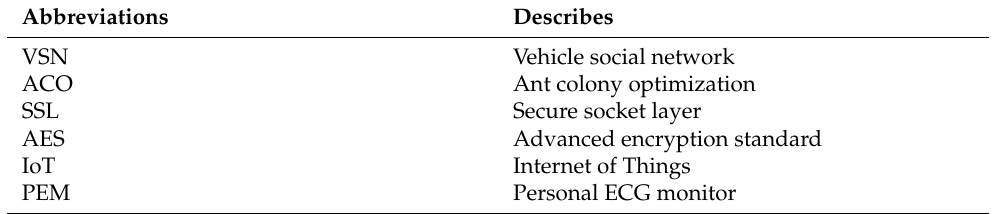
Table 1. Table of